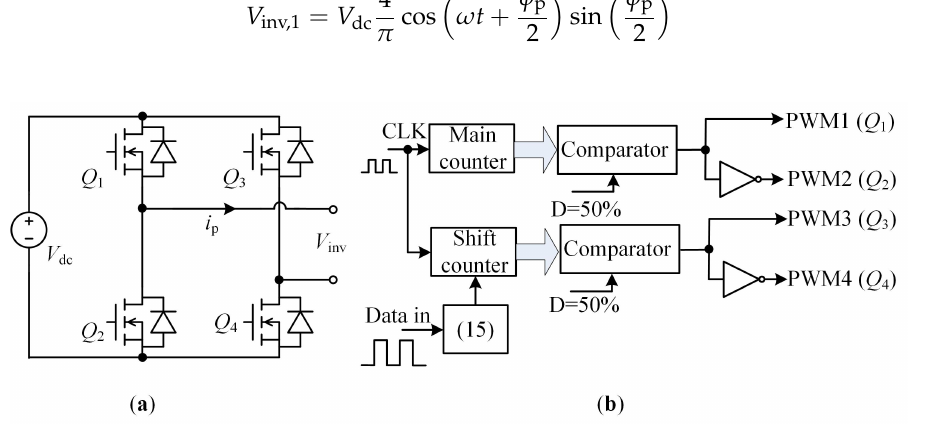
Figure 5. ( a ) Circuit of full-bridge inverter. ( b ) Block diagram of modulation system based on differential phase shift keying